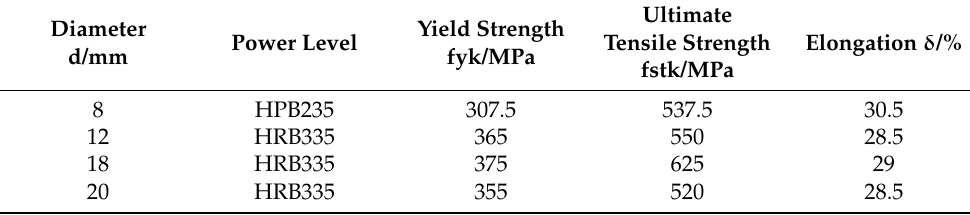
Table 1. Mechanical properties of steel bars